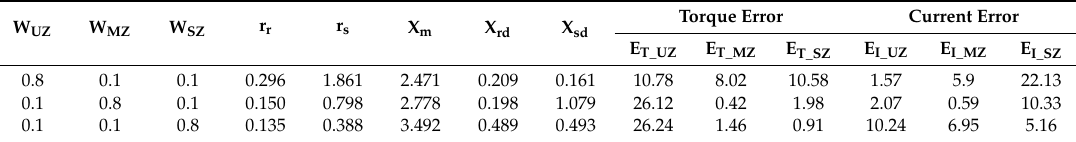
Table 3. Weights W Z , parameters are in p.u., torque error (E TZ ), and current error (E IZ ), where Z are the zones unstable (UZ), maximum (MZ), and stable zone (SZ) with W T = W I =